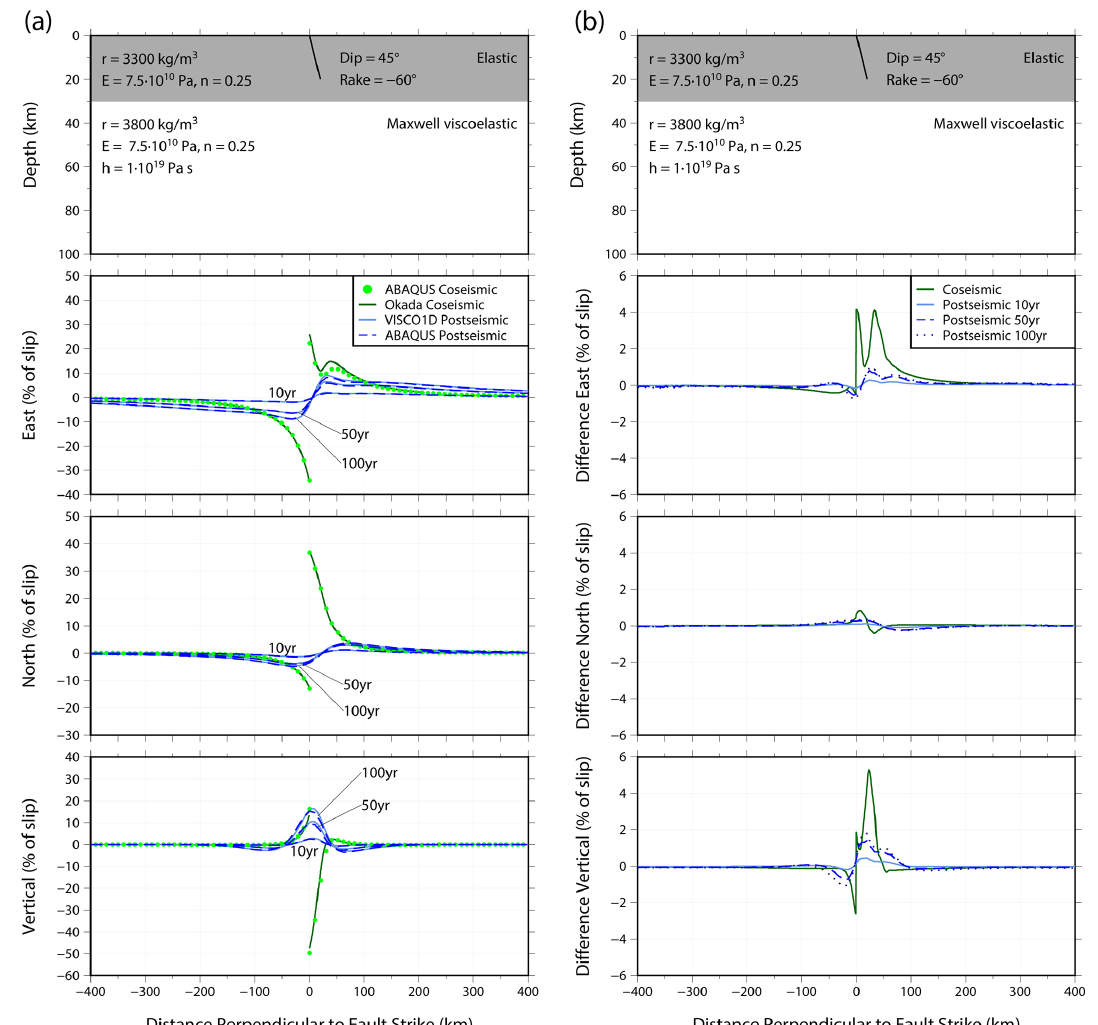
Figure 5. As for Fig. 3 but for a 45 ◦ dipping